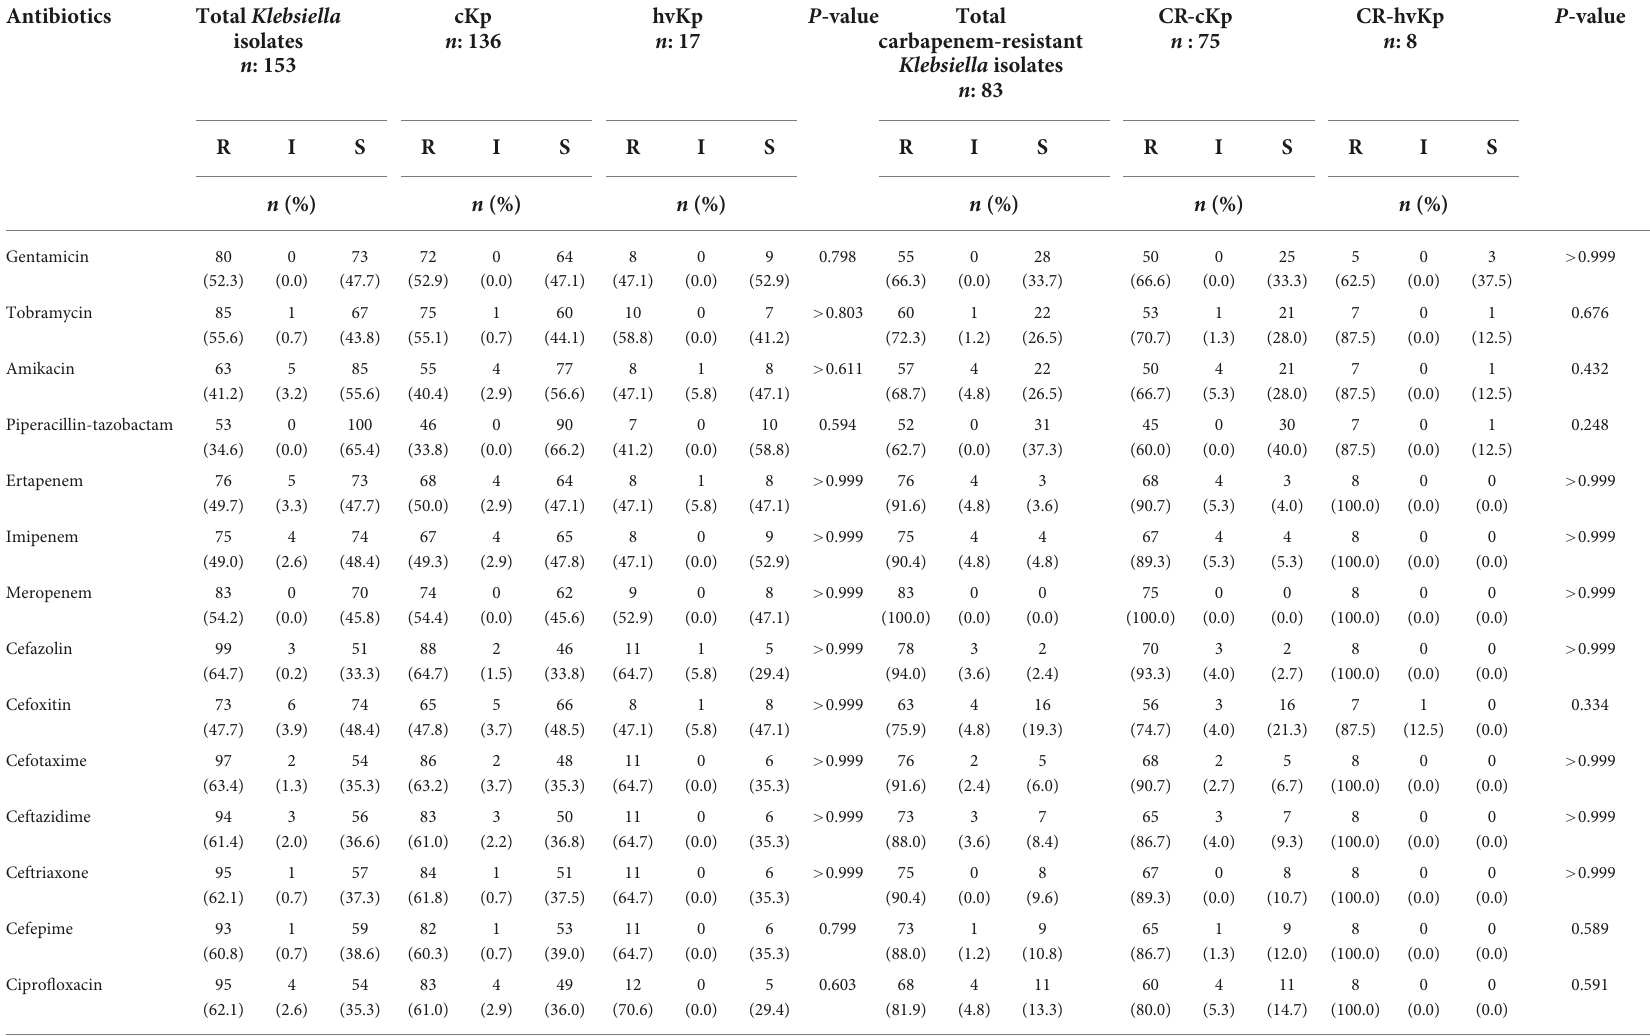
TABLE 2 Antibiotic resistance rates of classic Klebsiella pneumoniae (cKp), hypervirulent K. pneumoniae (hvKp), carbapenem- resistant classic K. pneumoniae (CR-cKp), and carbapenem-resistant hypervirulent K. pneumoniae (CR-hvKp) isolates.